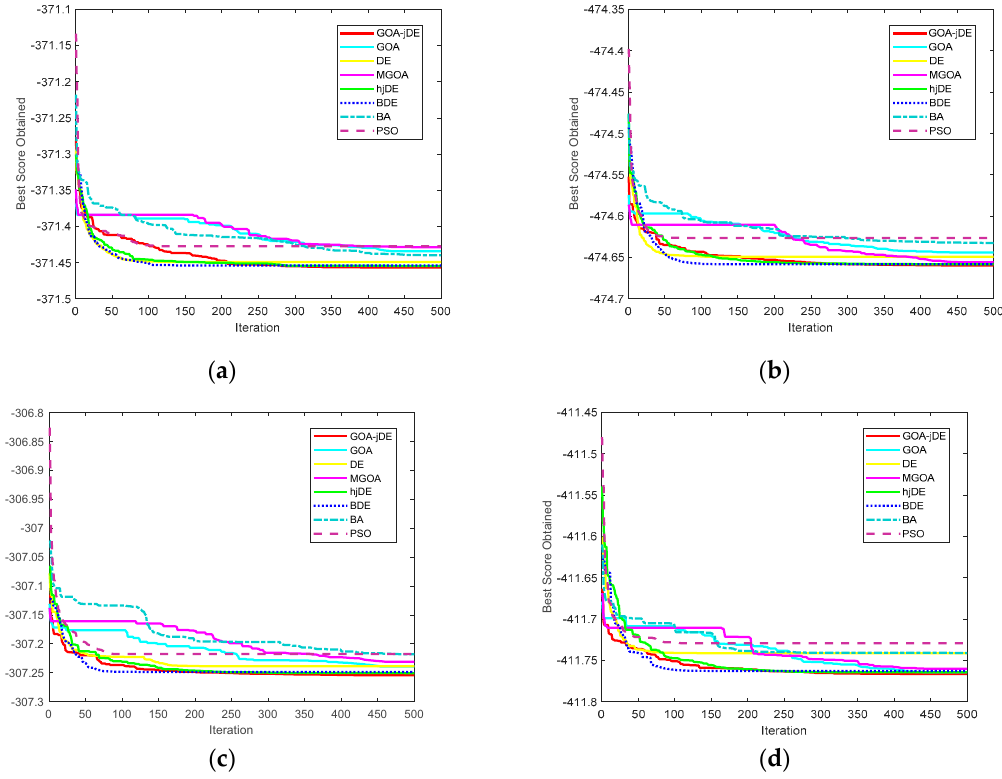
Figure 7. The convergence curves for fitness function using MCE method at 12 threshold levels. ( a ) Image2, ( b ) Image4, ( c ) Image6, ( d ) Image8.